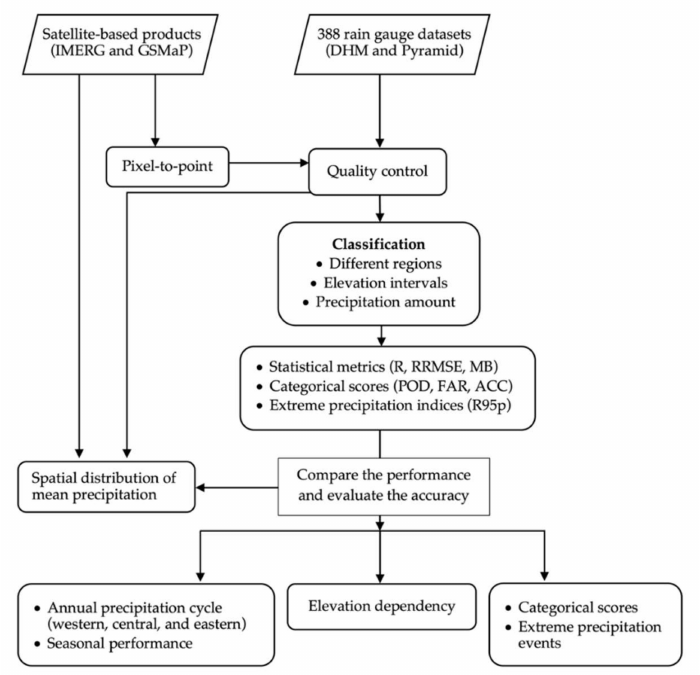
Figure 2. The flowchart of the overall processes followed in the